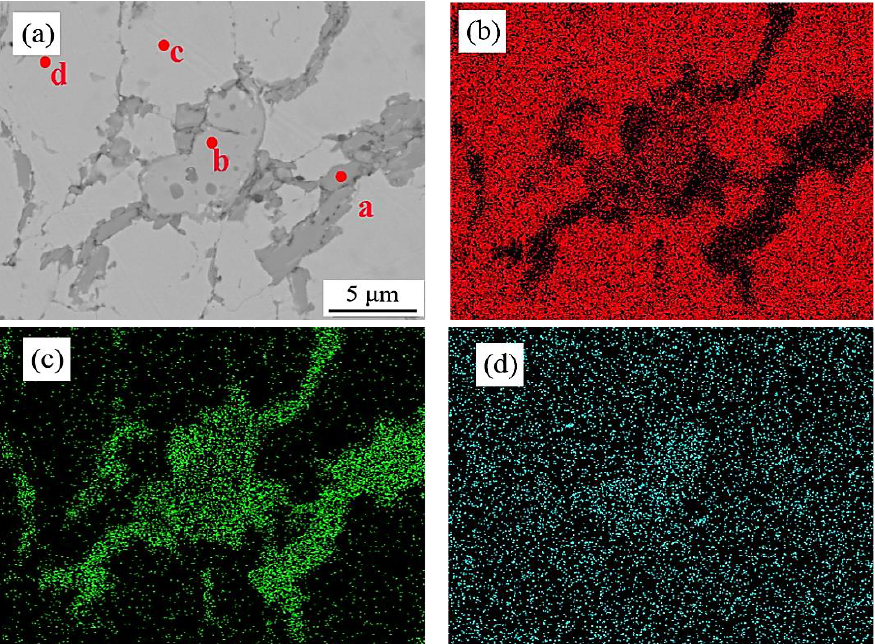
Figure 5. Typical morphology and EDS mapping of Ti 3 AlC 2 /Cu composites when the volume fraction of Ti 3 AlC 2 is 50 vol.%: ( a ) central Ti 3 AlC 2 particle almost decomposed; ( b ) scanning results of the Cu element, ( c ) the Ti element and ( d ) the Al element.